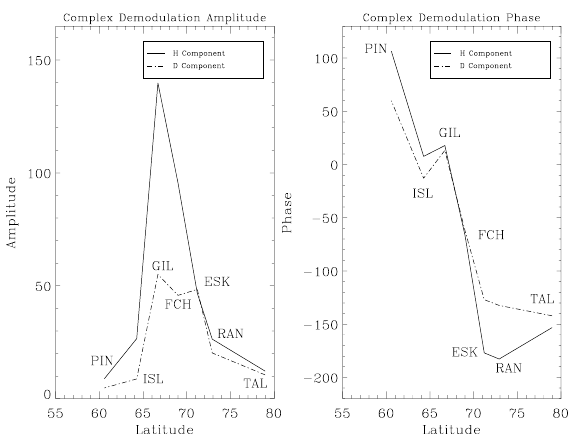
Fig. 4. Complex demodulation latitudinal amplitude (first panel) and phase (second panel) variations of the H and D -components of the 2.8mHz wave along the CANOPUS Churchill line, centred on 00:20UT.